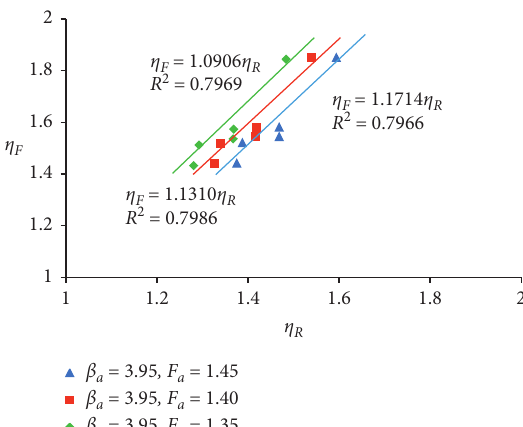
Figure 12: The correlation of η